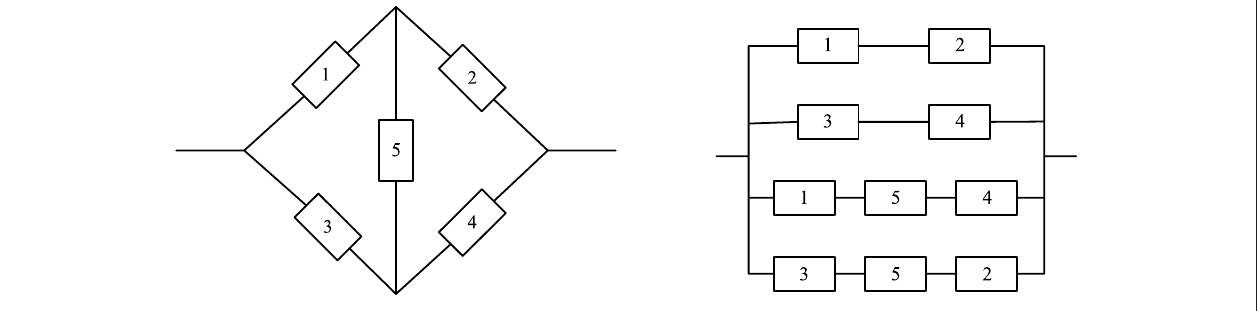
FIGURE 1 | Minimal path sets of typical